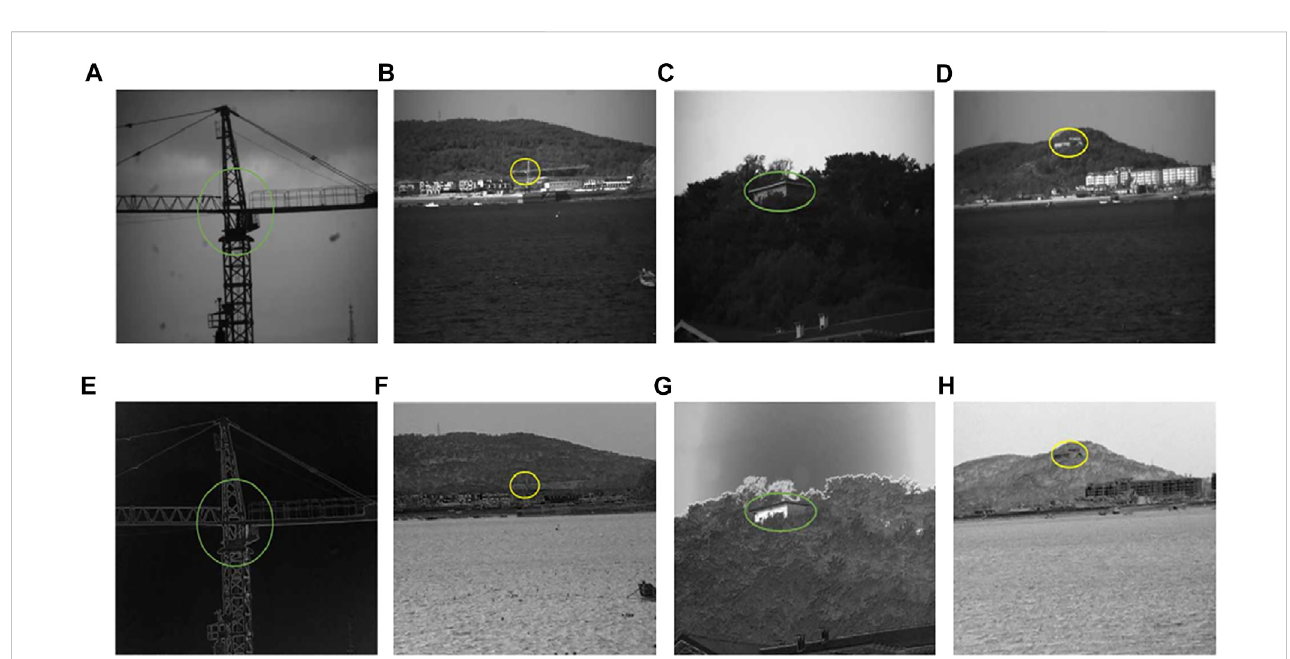
FIGURE 11 IntensityandPolarizationimagesfordifferentimagingdistances (A) 50 mIntensityimage (B) 1.5 kmIntensityimage (C) 100 mIntensityimage (D) 2.5 km Intensity image (E) 50 m Polarization image (F) 1.5 km Polarization image (G) 100 m Polarization image (H) 2.5 km Polarization